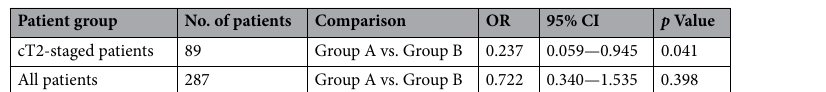
Table 4. Logistic regression comparing the 5-year risk of death between group A and B for all patients and the subgroup of cT2 patients.